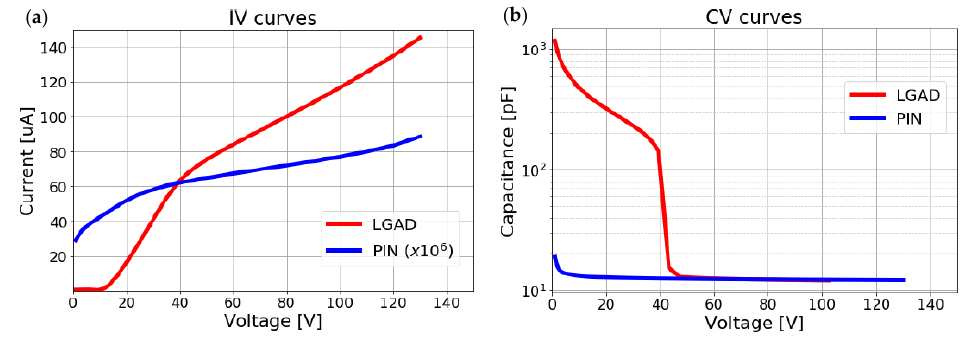
Figure 5. Electrical characterization of PIN and LGAD detectors: ( a ) I-V curves; ( b ) C-V curves.